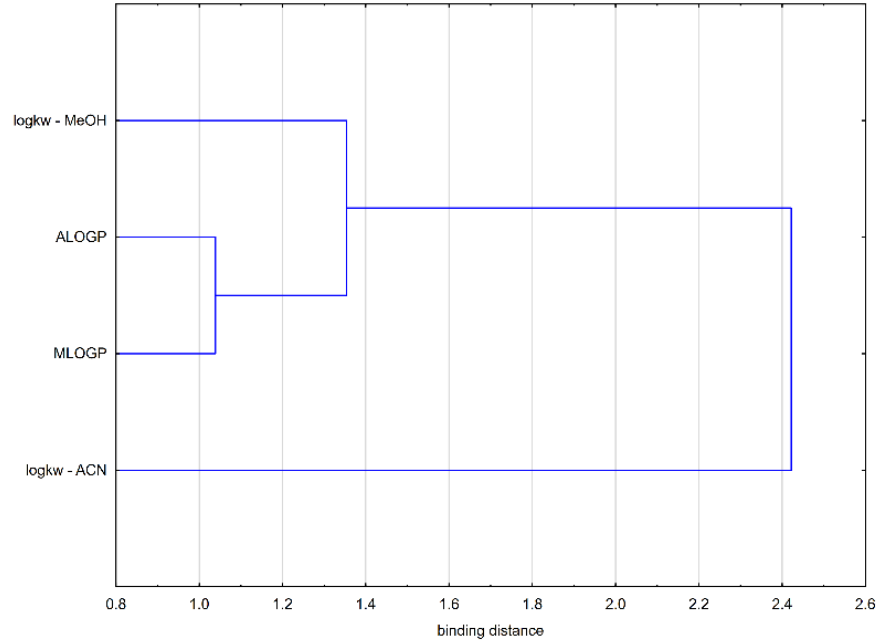
Figure 3. Dendrogram of lipophilicity parameters.